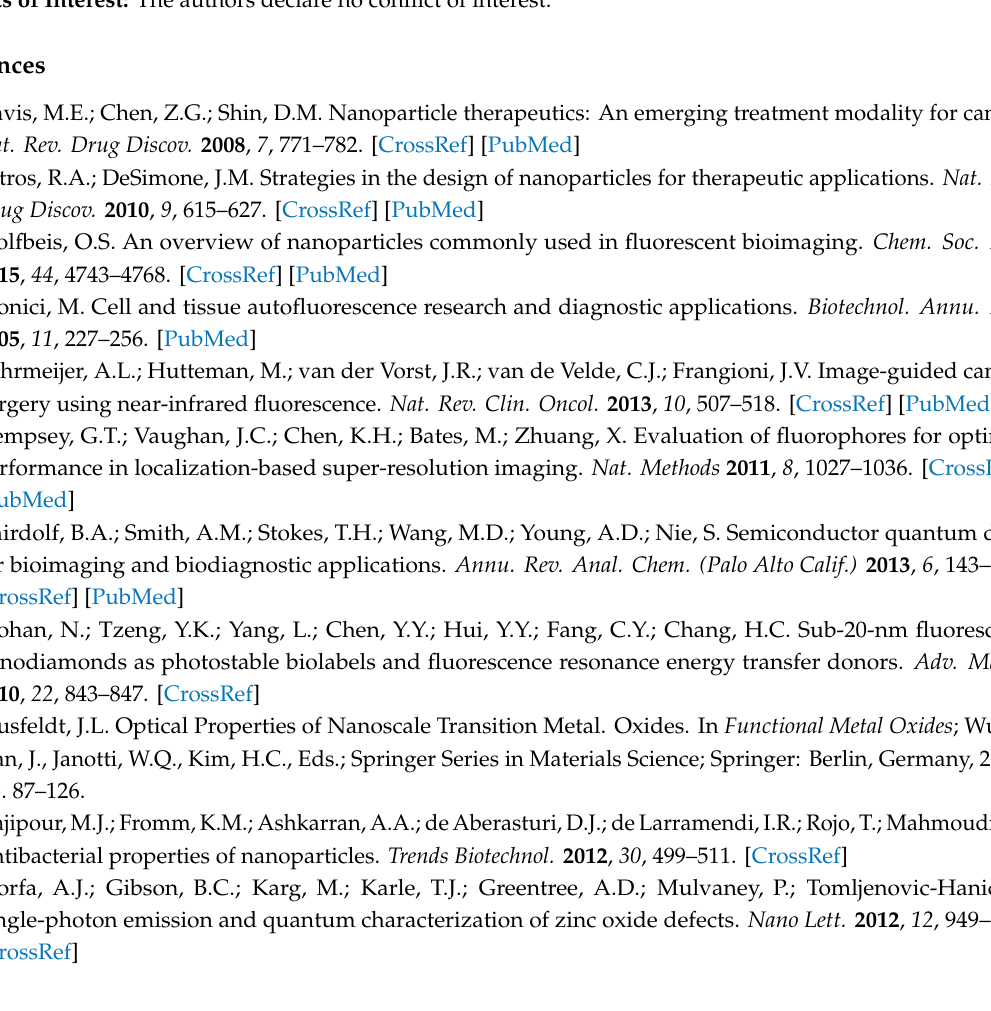
Figure S1: TEM images of (a) commercial MgO nanoparticles and (b) ball-milled MgO nanoparticles, Figure S2: (a) Example fluorescence decay trace measured from a single MgO (ball-milled) particle. The red line is a bi-exponential fit with time constants τ 1 and τ 2 , and respective amplitude A 1 and A 2 . The dotted-dashed line shows the instrument response. (b,c) Histograms of τ 1 (b) and τ 2 (c) obtained from measurements on about 20 particles of the commercial type (red) and ball-milled type (blue). (d) Histogram of A 2 , relative to the total amplitude A 1 + A 2 = 1, Figure S3: Cell viability of prostate cancer (PC-3) cells with MgO nanoparticles recorded for 24 h. Figure S4: DLS size distribution of commercial MgO NPs incubated in water (left), PBS (middle) and culture medium (right) after 24 h. The y-axis represents the amplitude of scattered light which is higher for larger